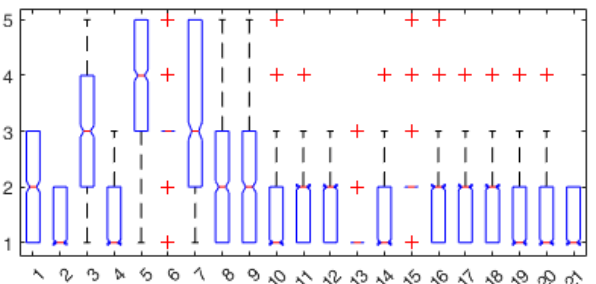
Figure 2. Box plot of 937 responses obtained from three major cities in